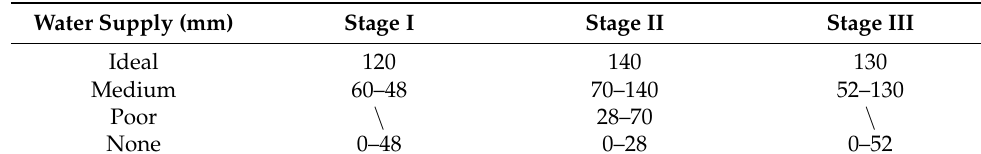
Table A2. Simplified supplied water amount to the barley at each stage.